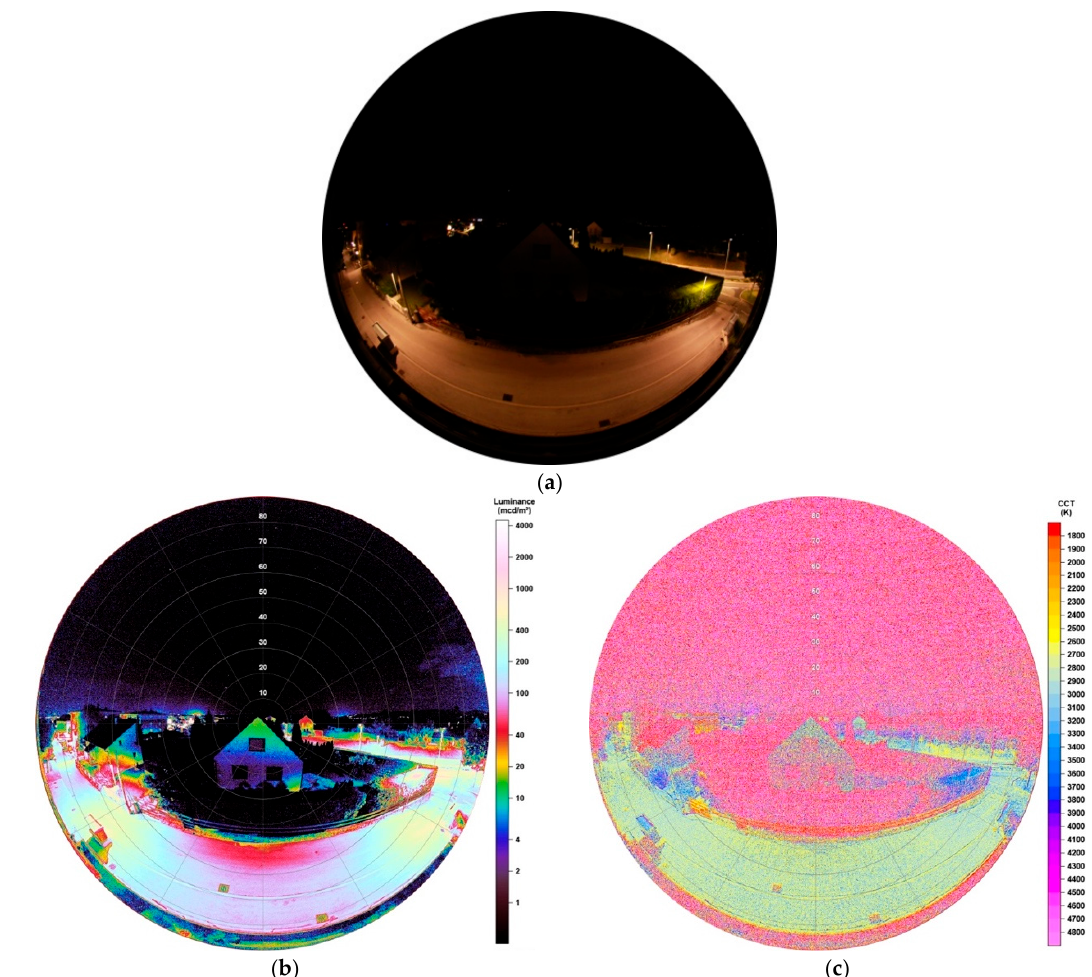
Figure 18. ( a ) Image of illuminated street and building during night-time after conversion to full cut-off-LEDs, taken with fisheye lens for detailed analysis (date: 02.07.2019, 02:03 h; exposure time: 0.5 s); ( b ) Luminance matrix as displayed by SQC; ( c ) CCT matrix as displayed by SQC.